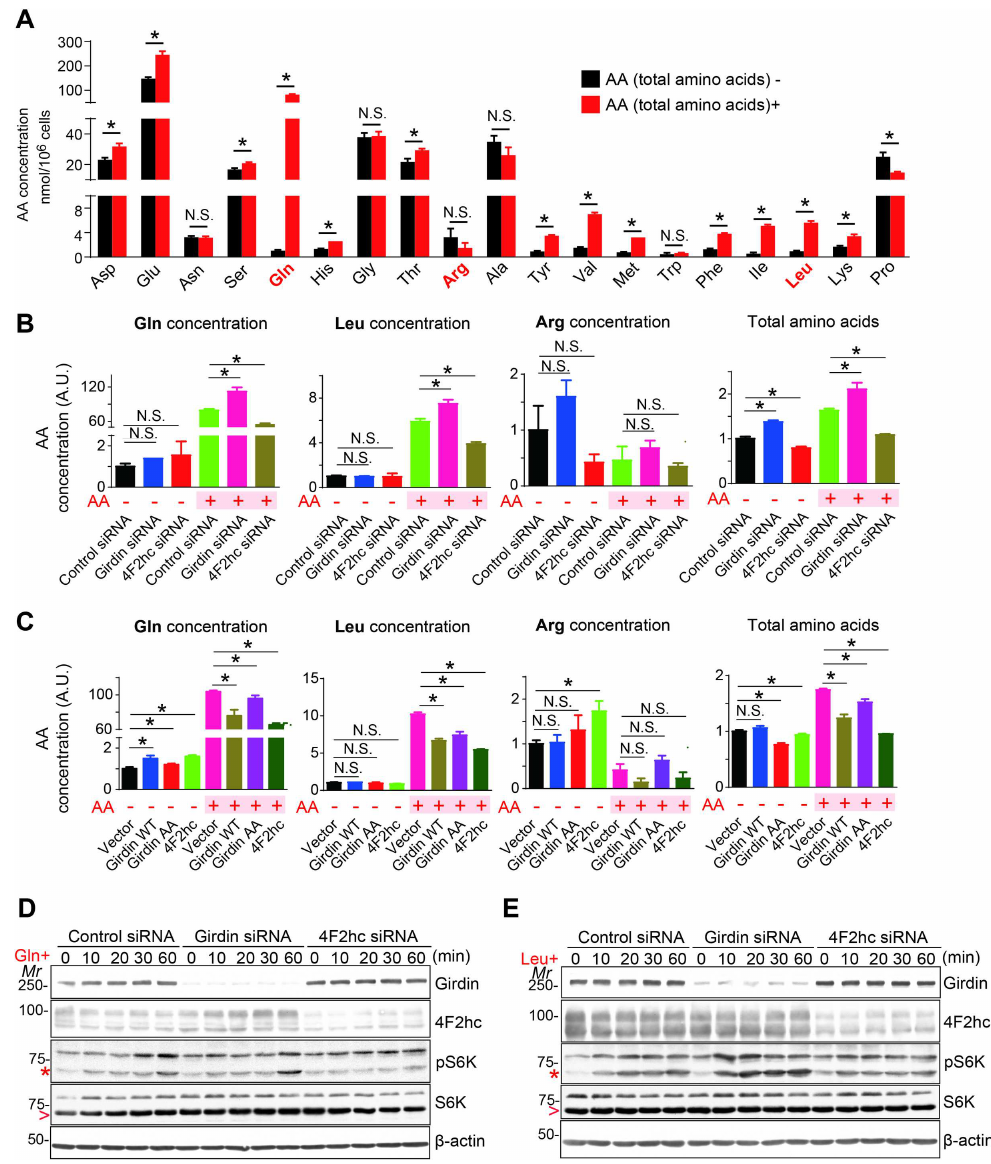
Fig 6. Girdin negatively regulates amino acid signaling through decreasing intracellular Gln and Leu contents. (A) 293FT cells starved for amino acids for 1 h were stimulated with total amino acids (AA+) for 10 min. Amino acid concentrations were measured with an HPLC system. Quantification of each amino acid concentration from 3 independent experiments is shown; the data are presented as means ± SEs. (cid:3) P < 0.05. The data underlying this figure can be found in S1 Data. (B, C) 293FT cells transfected with indicated siRNA (B) or Flp-in 293 cells stably expressing empty vector, Girdin WT, Girdin AA, and 4F2hc (C) were starved for amino acids for 1 h and stimulated with total amino acids for 10 min. Quantification of each amino acid concentration from 3 independent experiments is shown; the data are presented as means ± SEs. (cid:3) P < 0.05. The values in control cells (control siRNA or empty vector) starved for amino acids were set as 1. The data underlying this figure can be found in S1 Data. (D, E) 293FT cells transduced with control or Girdin shRNA were starved for 1 h in amino acid–free medium and stimulated with Gln (D) or Leu (E) for the indicated times, followed by WB. Note that the activation of mTORC1 was observed at 60 min in Gln stimulated cells (D) . AA, amino acids; Arg, arginine; A. U., arbitrary unit; Gln, glutamine; Leu, leucine; Girdin, girders of actin filaments; Mr , molecular marker;